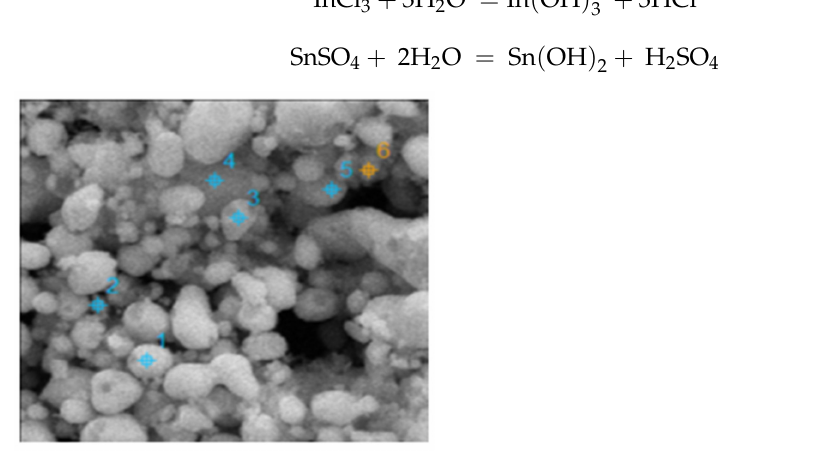
Figure 2. SEM image corresponding to the indium-tin alloy point sweep with the best sphericity (indium-tin ratio of 55/45). Table 1. Indium-tin raising quality ratio